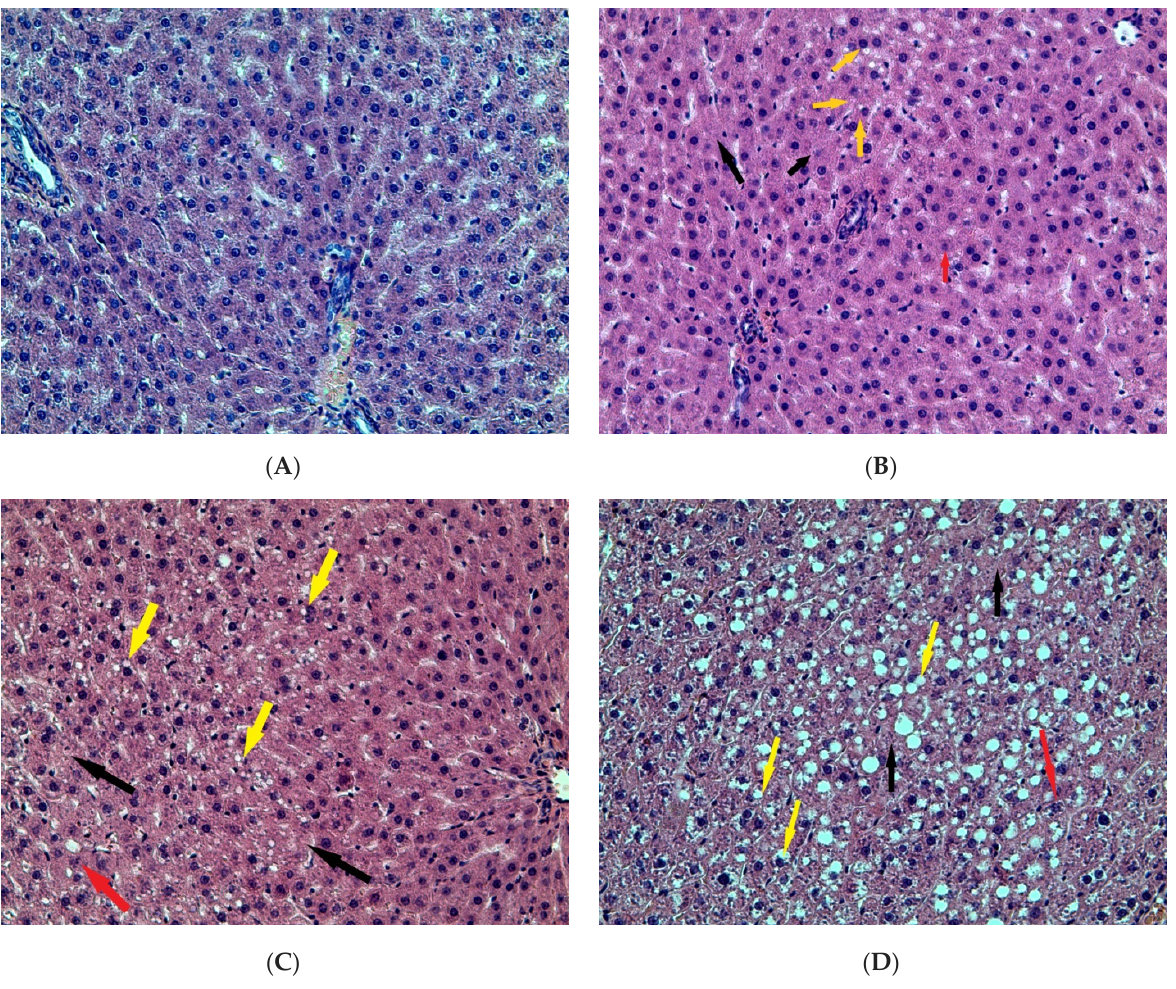
Figure 1. Liver of rats: ( A )—control; ( B )—EtOH; ( C )—CL; ( D )—EtOH + CL. Hematoxylin and eosin staining, × 200. Yellow arrows indicate hepatocytes in a state of fatty degeneration; red arrows— hepatocytes in a state of apoptosis; black arrows—hepatocytes in a state of necrosis.